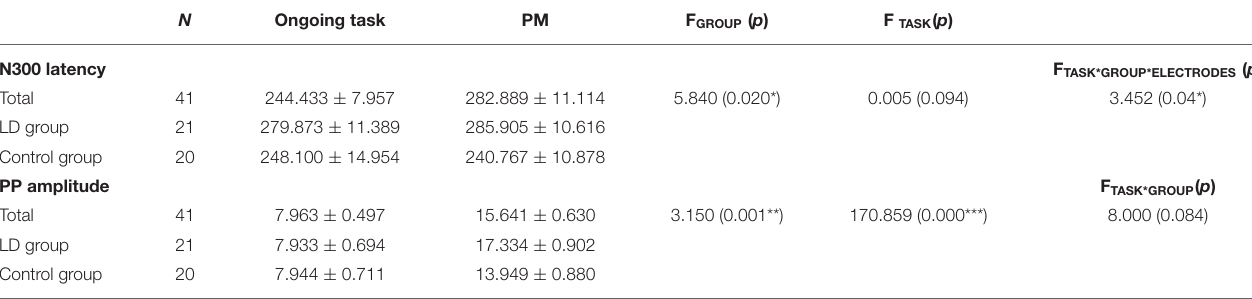
TABLE 2 | ERP components (M ± SD) for LD group and control